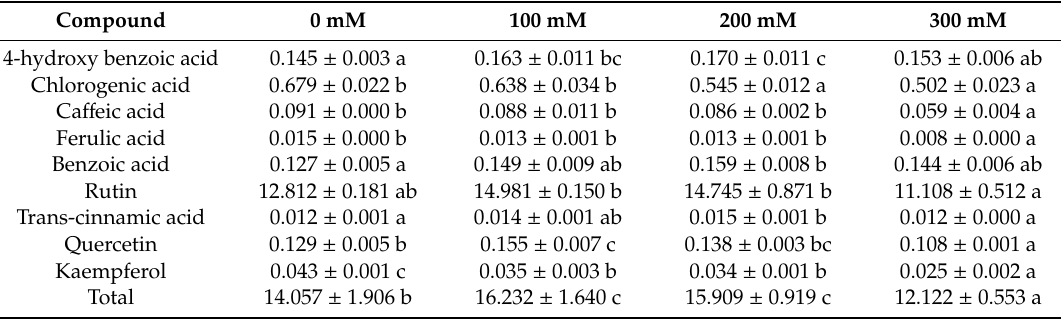
Table 1. The accumulation of phenolic compounds because of salinity stress in tartary buckwheat. (Average ± STDEV, mg/g dry wt.). The means and standard deviations were obtained from three independent experiments. Letters a–c indicate significant differences ( p < 0.05).